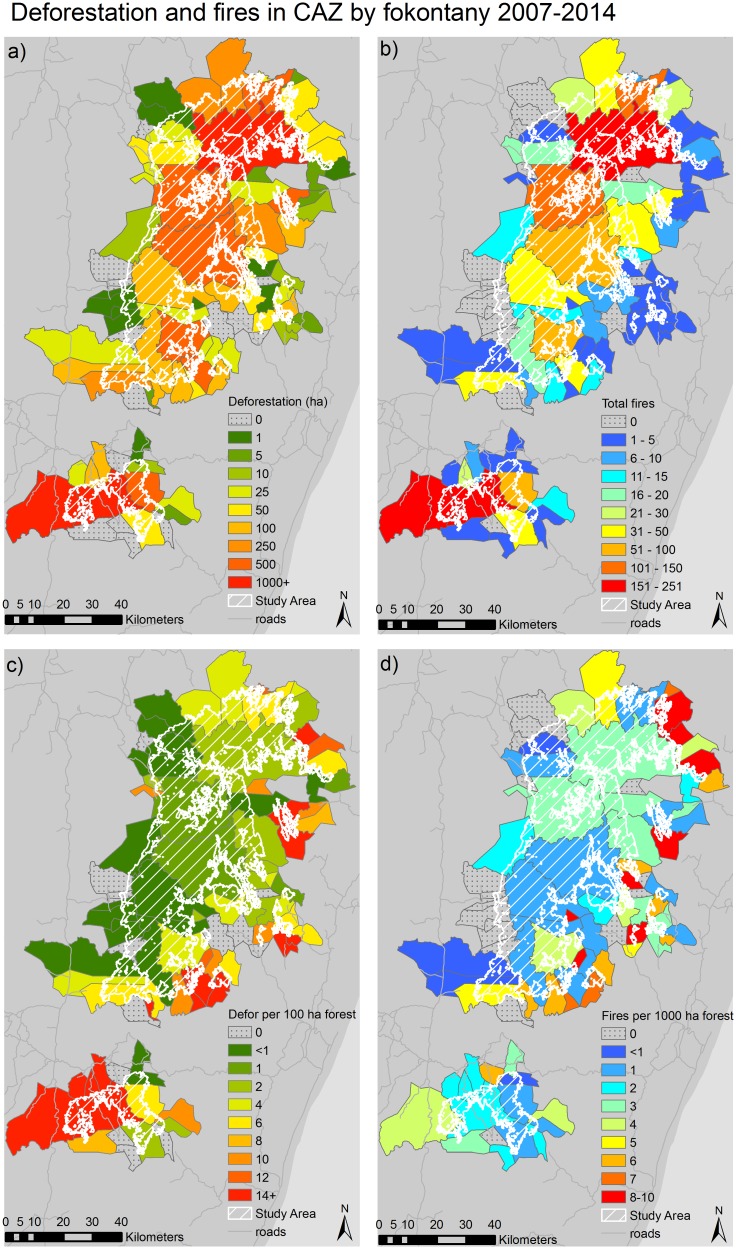
Deforestation and fires in CAZ by fokontany, 2007–2014.Spatial trends in (a) total deforestation (ha); (b) fire detections; (c) deforestation per 100 hectares of forest cover (c.2007); and (d) fire detections per 1000 hectares of forest (c.2007) in fokontany in CAZ.